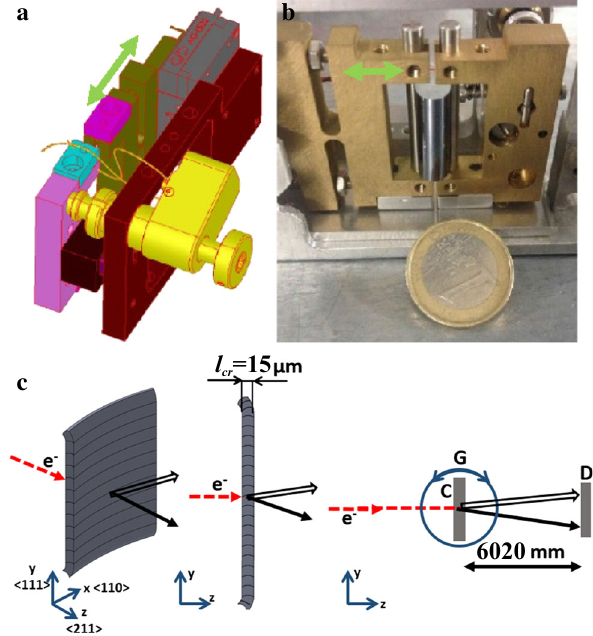
Fig. 2 a CADensembledrawingofthesampleholderfromabackview without the sample. The sample holder main component is a stepper motor(gray)thatcanactuateatranslationofamovablepart(green)with respect to a fixed one (brown). Two steel plugs are inserted respectively in the movable and in the fixed part. b Photo of the Si crystal sample mounted on the holder. The sample is glued in the two flat hollows carved in the plugs. The piezo-motor of the holder can adjust the distance between the two plugs in the direction highlighted by the double green arrows and thereby the crystal sample is forced to bend, as clearly visible in the photo. c left Bending of a silicon plate-like crystal with properly chosen crystallographic orientations generates the quasi- mosaic effect, resulting in a secondary bending of the planes lying in the crystal thickness. c right Sketch of the experimental setup, where the dashed arrow indicates the incoming beam, impinging on the bent crystal mounted on a high-precision goniometer (G), while the solid- black arrow indicates particles deflected under the channeling mode, and the solid-white arrow corresponds to VR particles. The deflected beam impinges on the LYSO Screen (D). c is adapted from Ref.